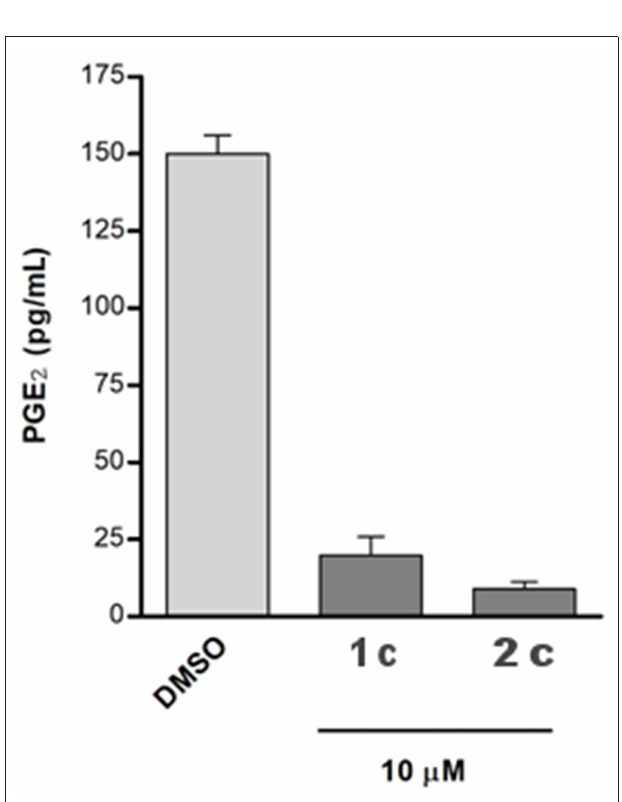
FIGURE 7 | The A549 cells were incubated for 24h with 10 µ M of compounds in conditioned medium (1% FBS and 10ng/mL IL-1 β ). The PGE 2 released into medium was quantified using a specific ELISA kit assay. The results were compared with that of the control cells IL-1 β stimulated and treated with chemical vehicle (DMSO) and are expressed as mean ± SEM (pg/mL) of two different